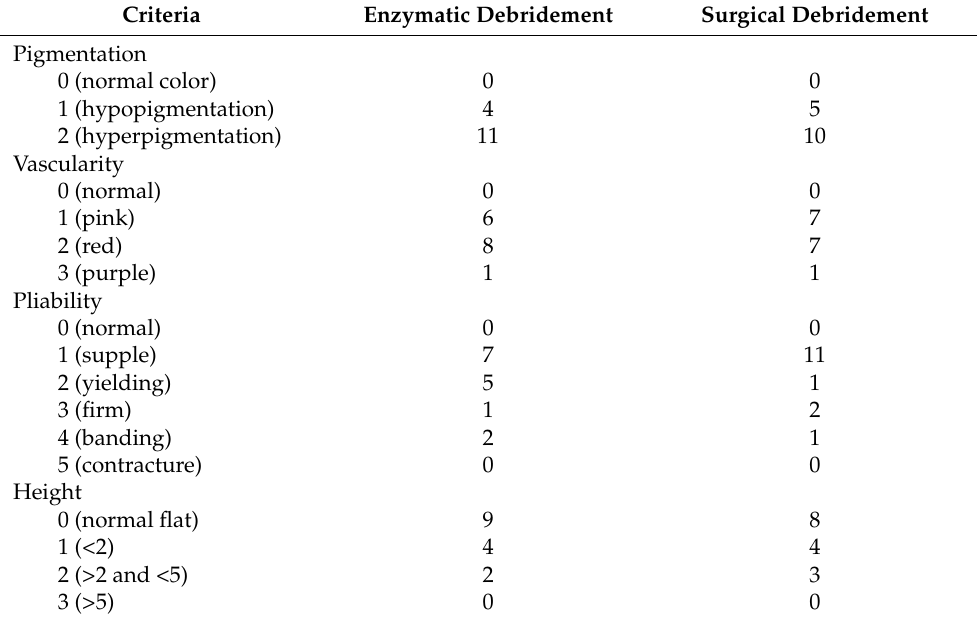
Table 3. Vancouver Scar